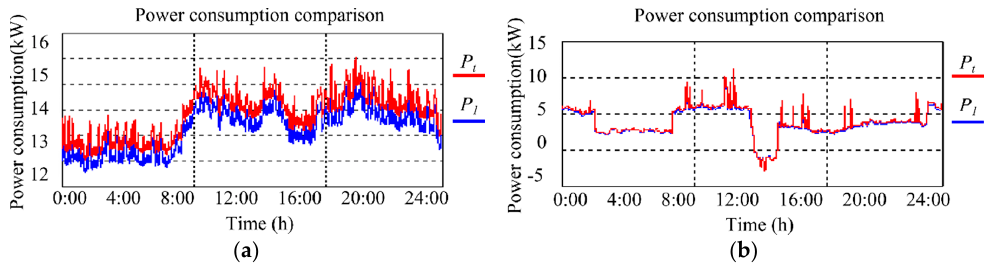
Figure 8. Power consumption difference estimation in: ( a ) main board MBD3; and ( b ) secondary board SB3.1.1. board